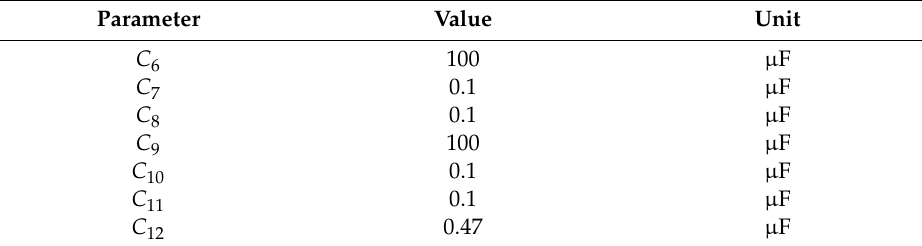
Table 10. Relevant parameters of the power supply circuit.